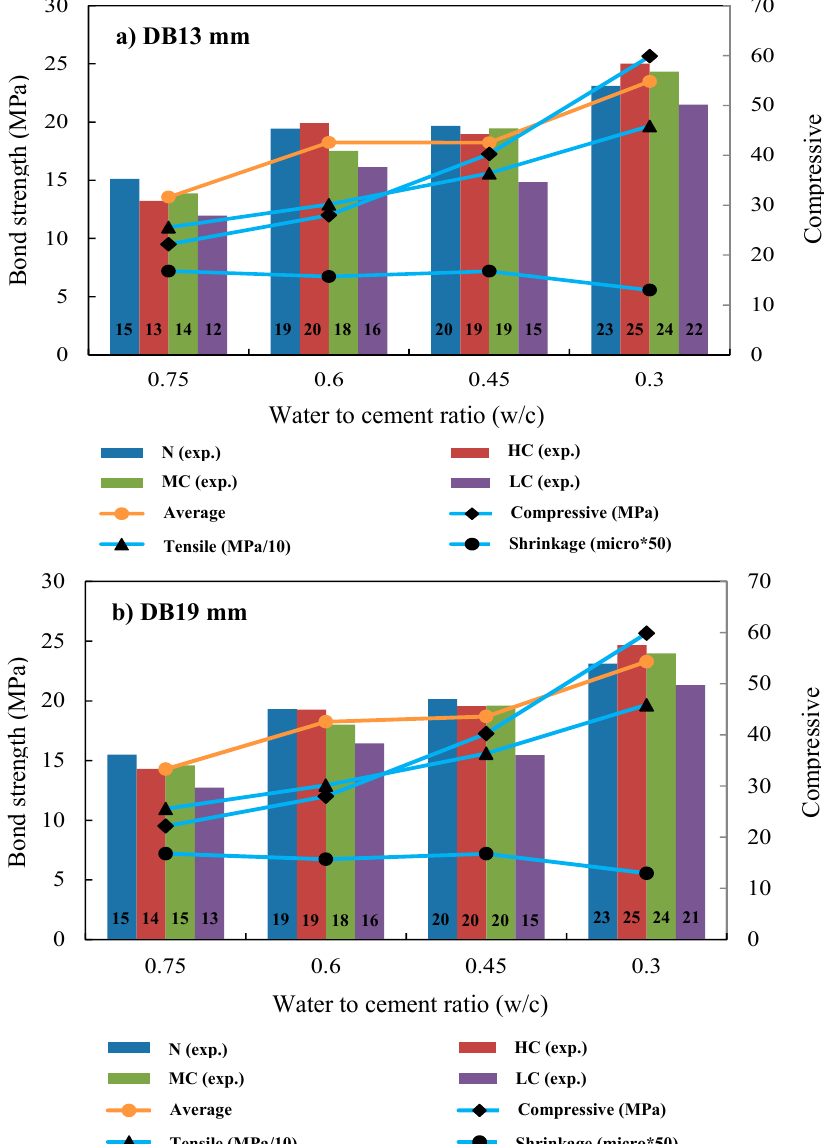
Figure 13. Bond strength between the steel rebar and concrete with different water-to-cement ratios and bar diameters. ( a ) DB13 mm and ( b ) DB19 mm.